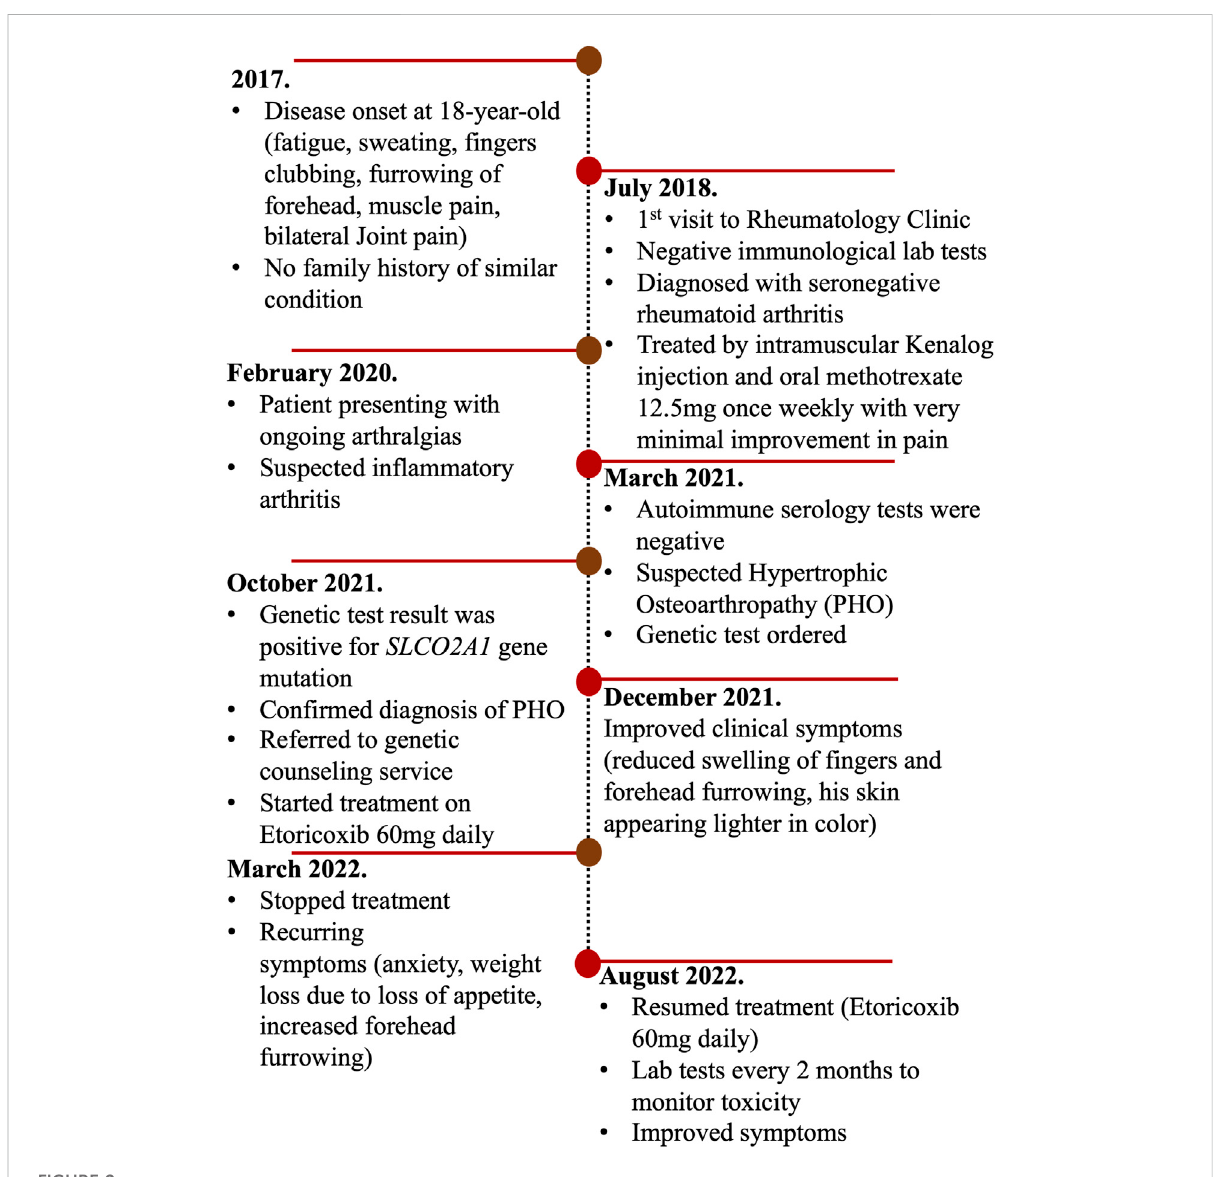
FIGURE 2 Timeline of the patient ’ s journey and care presented according to CARE